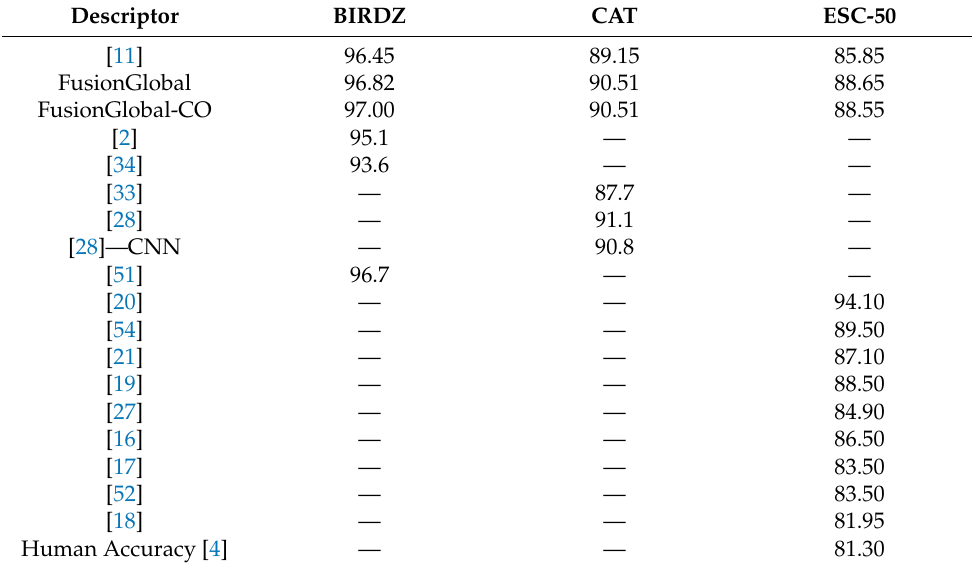
Table 6. Comparison of our best sound classification ensemble with state of the